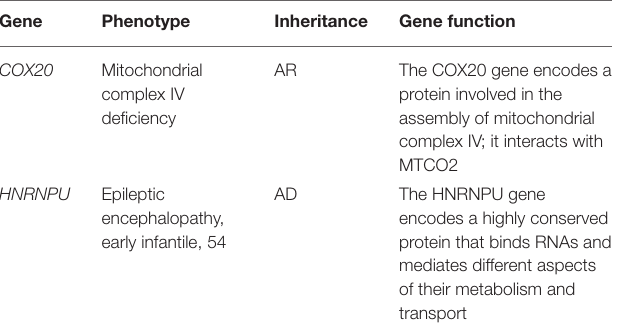
TABLE 1 | The deleted protein coding genes in the 1q44